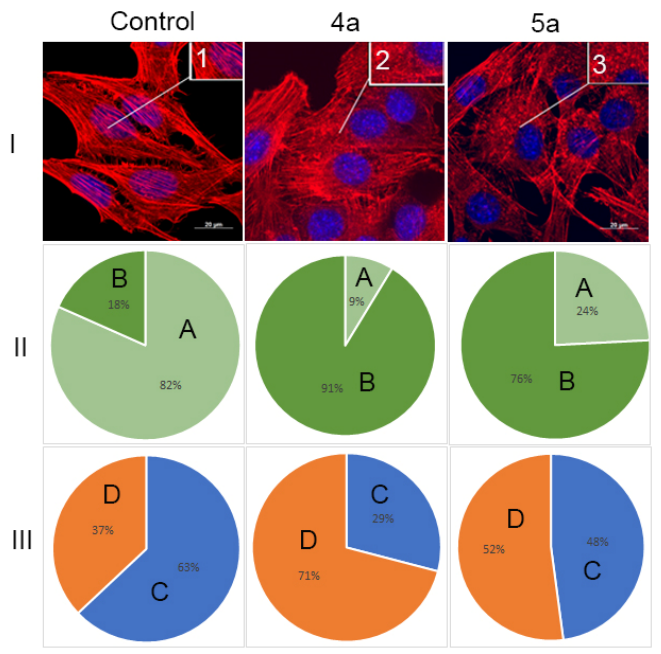
Figure 8. State of actin cytoskeleton of HeLa cells after treatment with spiro-fused tryptanthrines and pyrrolo[3,4- a ]pyrrolizines 4a and 5a . ( I ): Images demonstrate the different stages of cell actin cytoskeleton. ( II ): Pie charts demonstrate percentage of cells with normal stress fibers ( А ) and dis- assembled stress fibers ( В ). ( III ): Pie charts demonstrate percentage of cells with filopodia-like de- formations (C), and without filopodia-like deformations (D). Inserts: 1—stress fibers; 2—disassembled stress fibers.